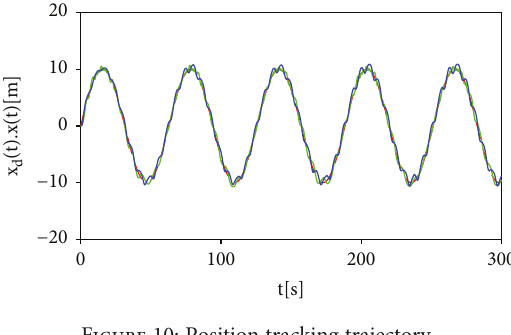
Figure 10: Position tracking trajectory.